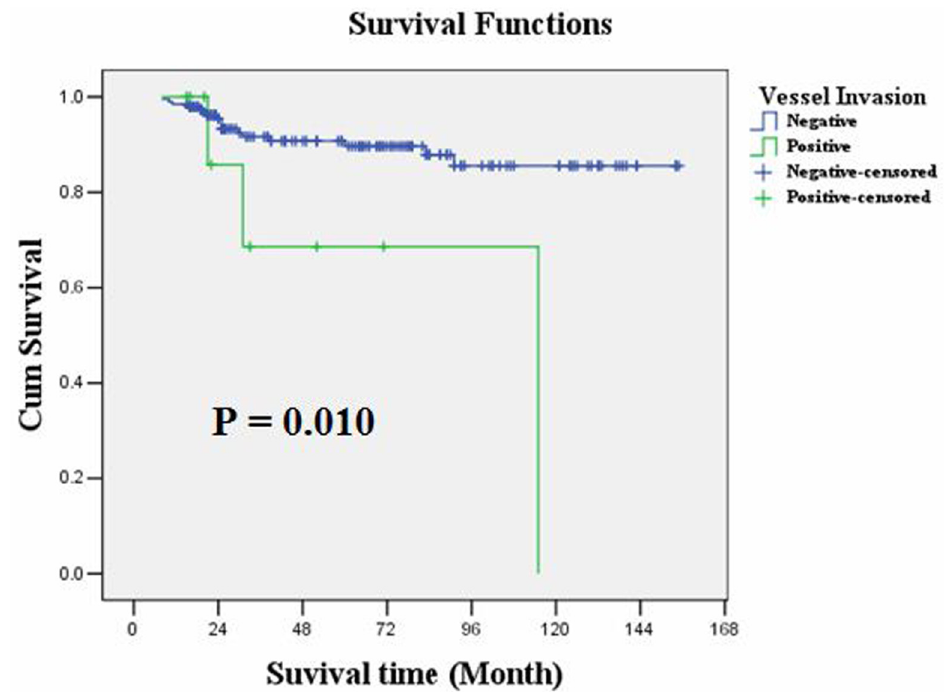
Fig 5. Kaplan-Meier survival analysis showed that overall survival of EGC was significantly correlated with invasions of lymphatic or blood vessels (P = 0.010).